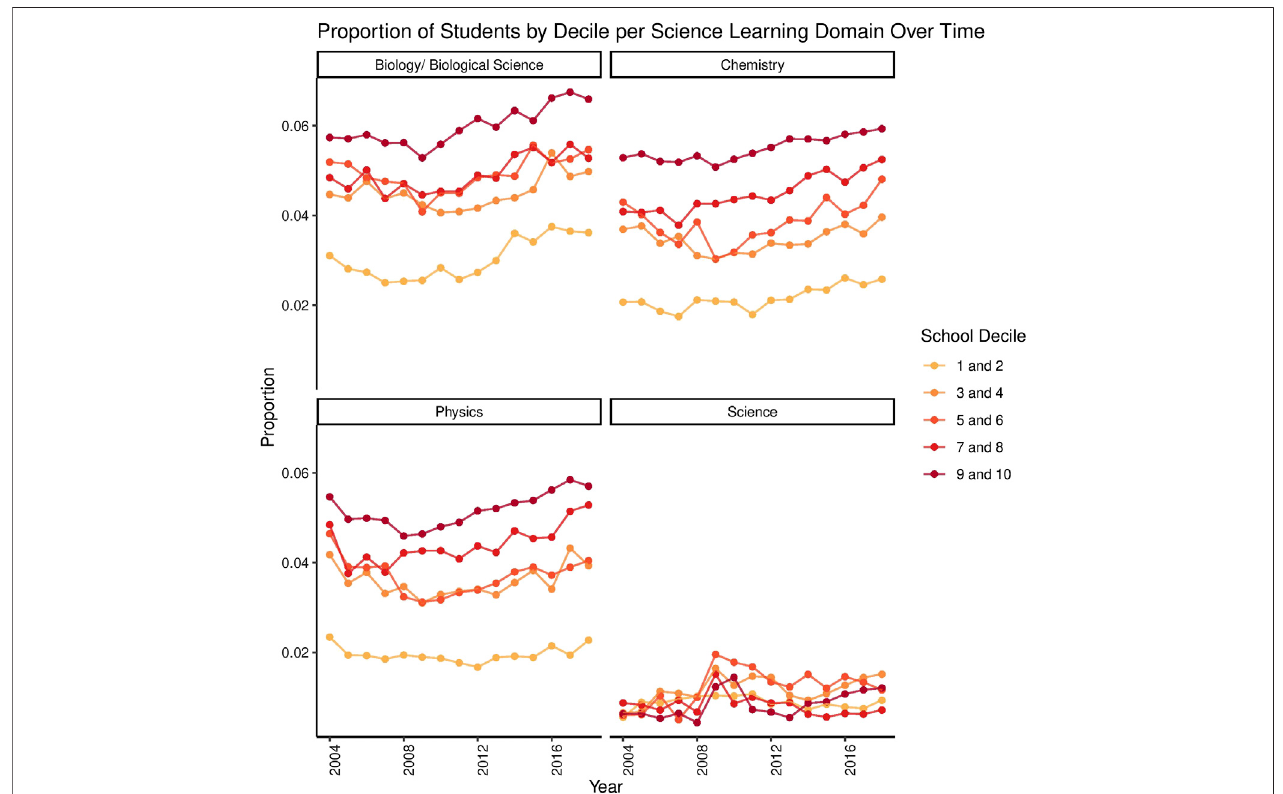
FIGURE 3 | Science Participation Rates Across Years by School Decile. School deciles are grouped into quintiles (deciles one and two together, deciles 3 and 4, and so on). These plots show the rate of participation for each decile group as a function of the total subject enrolments (across all learning domains) for that group. This takes into account that higher decile groups contain a greater number of students than lower deciles. As can be seen in the above plots, students from higher decile schoolsaremorelikelytotakebiology,chemistry,andphysics.Lowdecileschoolshada fl atterparticipationrateinphysics,butincreasingparticipationovertimein biologyandchemistry,suchthattheincreaseissimilartohigherdecileschools.Theplotofthecore “ Science ” subjectappearslessorderedandmorevariableintermsof decile ordering, but also has a lower rate of participation overall. Data retrieved from Ministry of Education (2018).